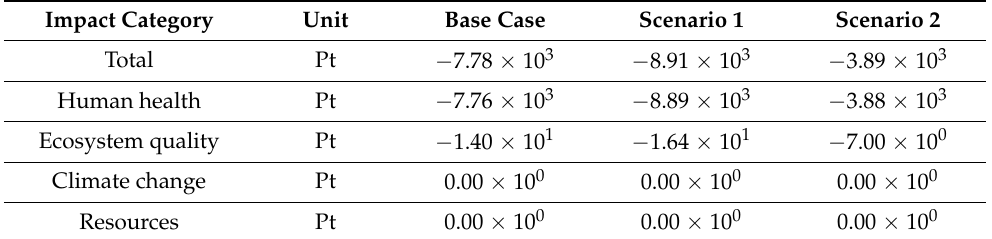
Table 5. Annual reduction of environmental impact in the three scenarios proposed. Impact Category Unit Base Case Scenario